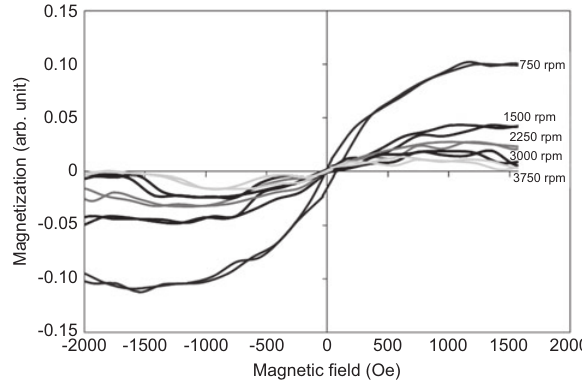
Figure 4 Hysteresis loops of PVDF composites with 10 wt % Ni prepared from varying spin coating speeds from 750 to 3750 rpm.